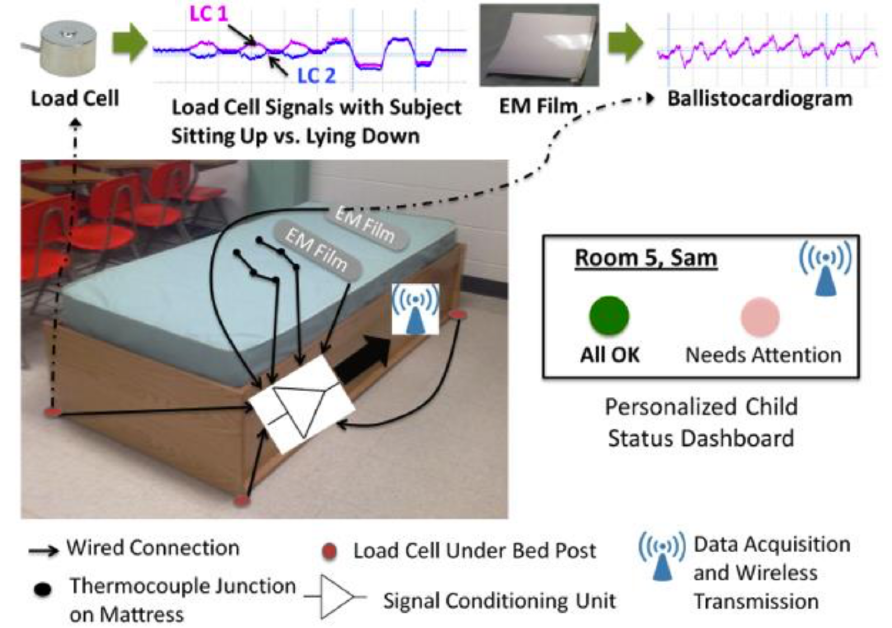
Figure 8. The bed sensor suite and the residential dashboard interface indicating the real-time status of the child on the bed. Sample data shows movements and ballistocardiogram (BCG) data ( c (cid:13) 2014 IEEE. Reprinted with permission